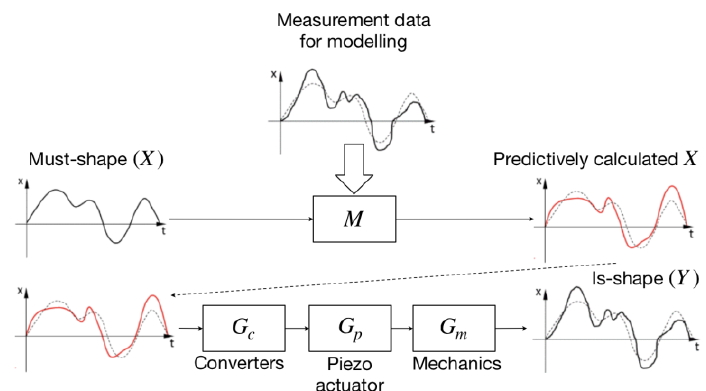
Figure 3. Iterative process: Schematic representation of the iterative incorporation process as a “manual control loop”.